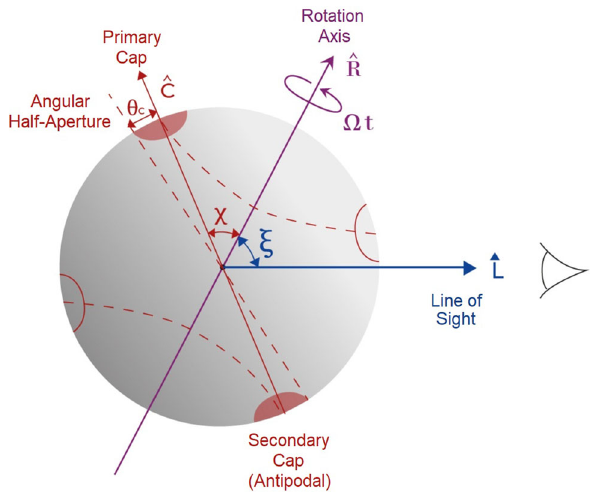
Fig. 4 Angular configuration between the observer ˆ L , the rotation axis ofthestar ˆ R andthecenteroftheemittingcap ˆ C ,ofangularhalf-aperture θ